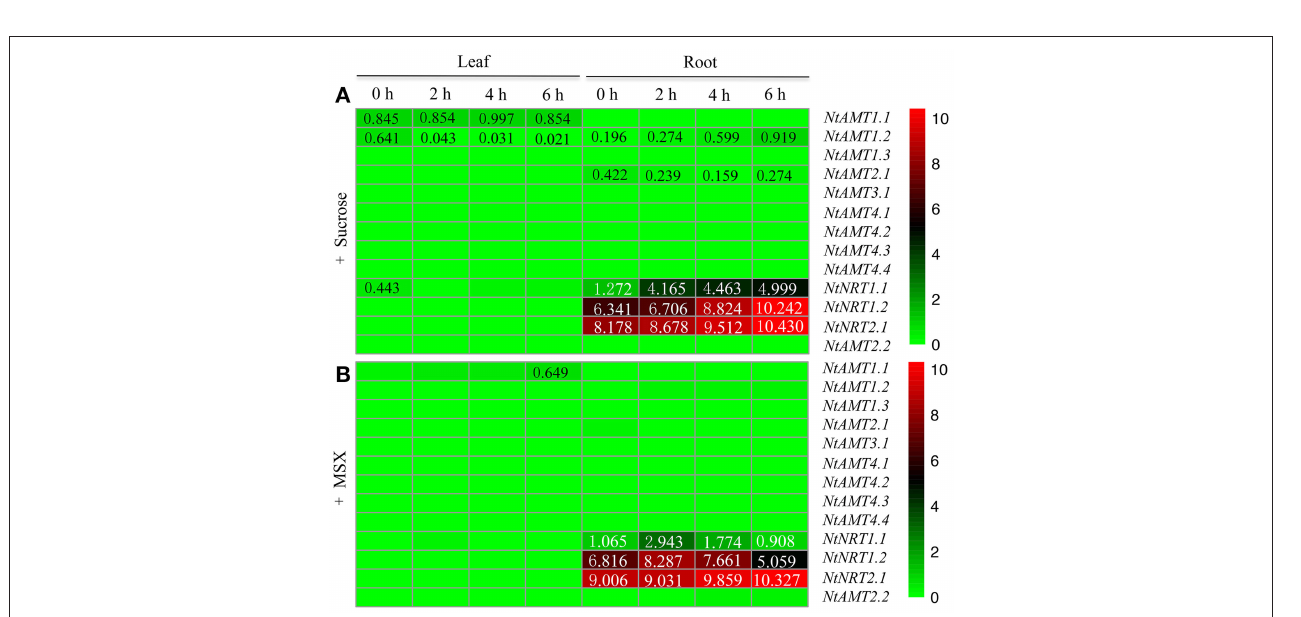
FIGURE 5 | Heat map of transcriptional regulations of AMTs and NRTs in tobacco K326 by external sucrose and MSX. Plants were hydroponically grown (for 15 d) in normal nutrient solution and treated with 1% sucrose (A) or 1mM MSX (B) for a time period of 0, 2, 4, or 6h (see section Materials and Methods). Total RNA was extracted from roots and leaves (1 d after fully-opened); relative mRNA abundance of NtAMTs and NtNRTs was quantified by using qPCR, and the expression level of AMTs and NRTs relative to that of L25 (set to 1) in each sample was calculated (see section Materials and Methods). A relative gene-expression abundance (derived from a difference of transcript levels between with and without MSX- or sucrose-treatment at each time point, except for time 0) was presented in a false color scale, where green or red color indicates respectively a lowest or highest expression with an absolute mean value at 0 or 10.